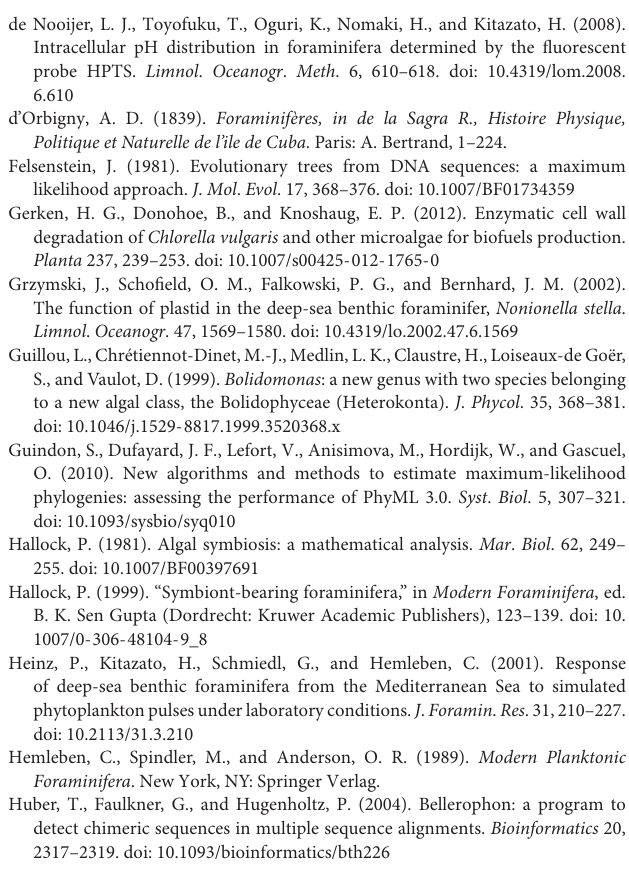
(B) Scale bar = 2 µ m. (C) Scale bar = 5 µ m. (D) Scale bar = 2 µ m. (E) Intact Chlorella chloroplast and the residues of food materials in the food vacuole (fv). Scale bar = 1 µ m. (F) Fractionated cell wall of Chlorella (arrowheads). Fibrillar structures on the surface of the Chlorella cell wall, low-density layer, and inner membrane are visible. Dense mitochondria (m), peroxisomes (p) are present. Scale bar = 1 µ m. FIGURE S7 | Phylogenetic tree of the internal transcribed spacers (ITS) of nuclear rRNA for host Planoglabratella species based on Bayesian inference. Numbers above the internal branches at the nodes indicate the posterior probabilities. Accession numbers follow the species names. FIGURE S8 | Statistical analyses of the autofluorescence during the culture periods. Data represent mean ± standard deviation during the culture periods in each culture condition for (A) food conditions and for (B) light conditions (Two-way ANOVA P < 0.05). An asterisk denotes significant differences between each condition. FIGURE S9 | Statistical analyses of the autofluorescence fluctuation during the culture period for (A) food conditions and for (B) light conditions. Data represent mean ± standard deviation during the culture periods in each culture condition for (A) food conditions and for (B) light conditions. Different letters stand for significant difference ( t -test, p < 0.05). FIGURE S10 | Statistical analyses of the pH fluctuation during the culture period. Data represent mean ± standard deviation during the culture periods for (A) specimen #1 and for (B) specimen #2 ( t -test, P < 0.05). The black box indicates pH values in the ultimate chamber (Region 1), and the gray box indicates pH in the inner chamber (Region 2). An asterisk denotes significant differences between each